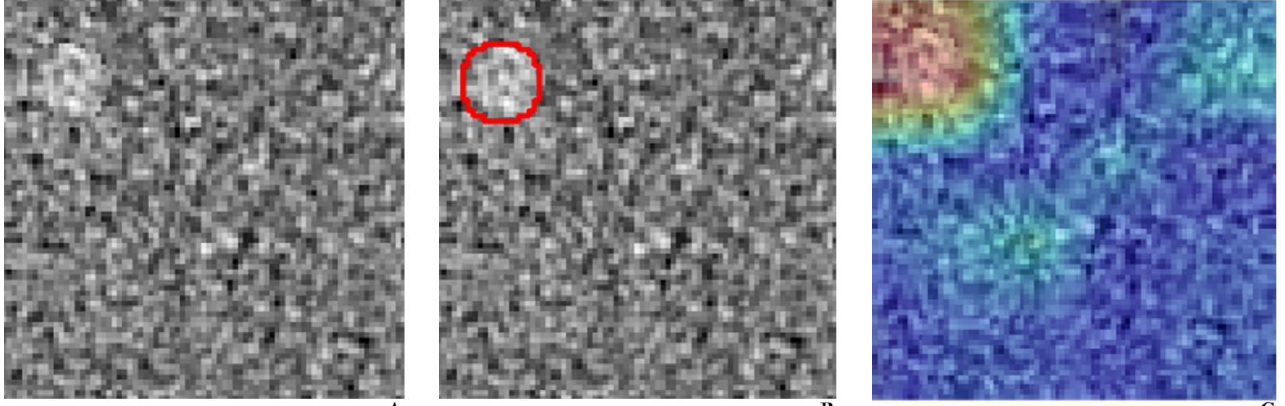
Figure 3. CT phantom image with a 9 mm object at the left upper quadrant, with a superimposed heatmap using gradient- weighted class activation mapping. ( A ). CT phantom image acquired under 100 kVp, 200 mAs, reconstructed with ADMIRE, with a 9 mm object, as ( B ). localized in a red circle. ( C ). Corresponding class activation map highlighting the activation in the left upper quadrant.